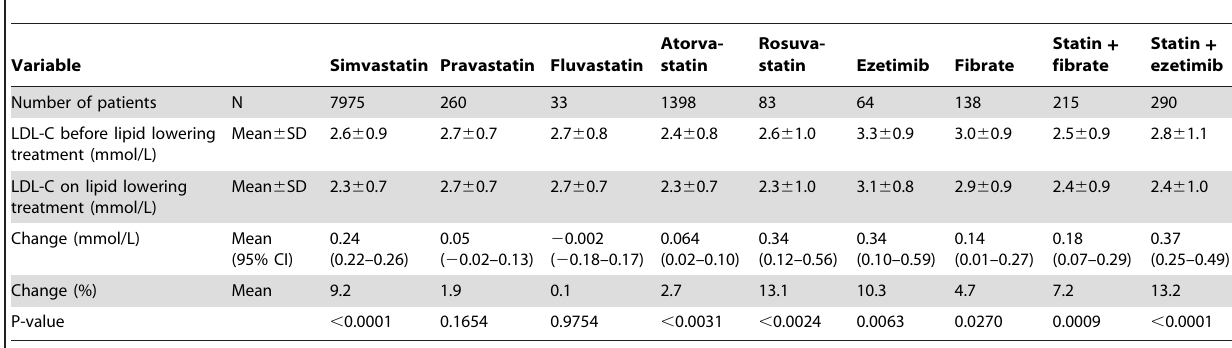
Table 4. LDL cholesterol values of patients on lipid lowering treatments before and on treatment in 2008.